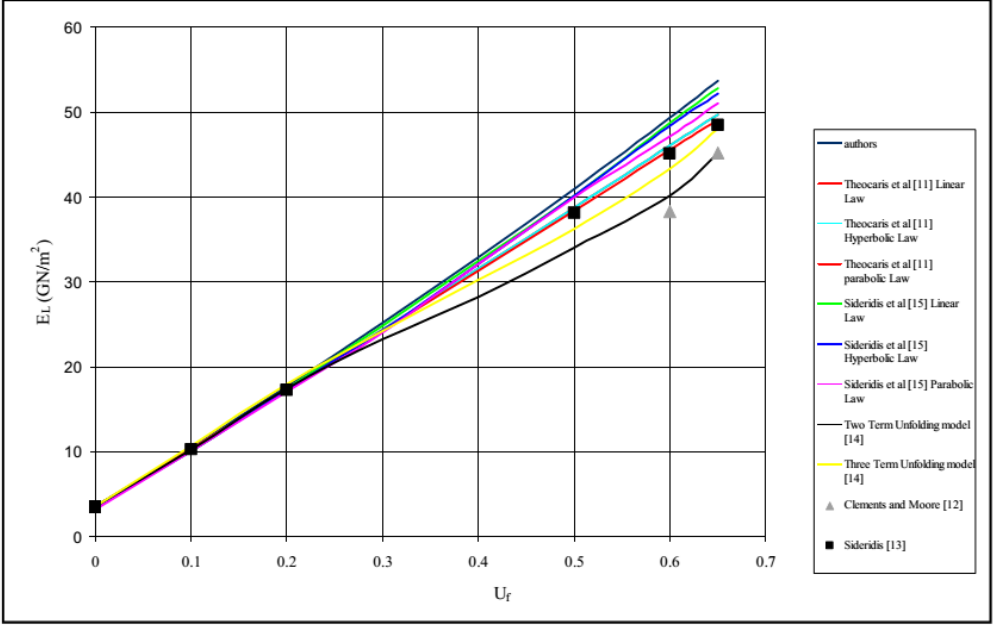
Figure 3. Variation of Longitudinal modulus against fibre volume